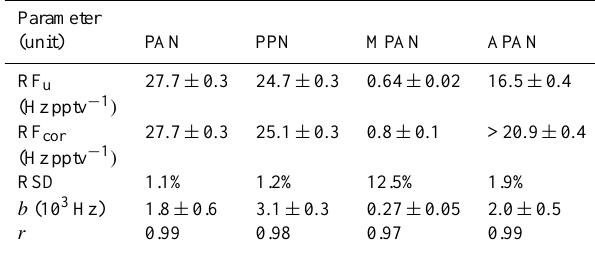
∗ Corrected for PAN-like impurities (see text).